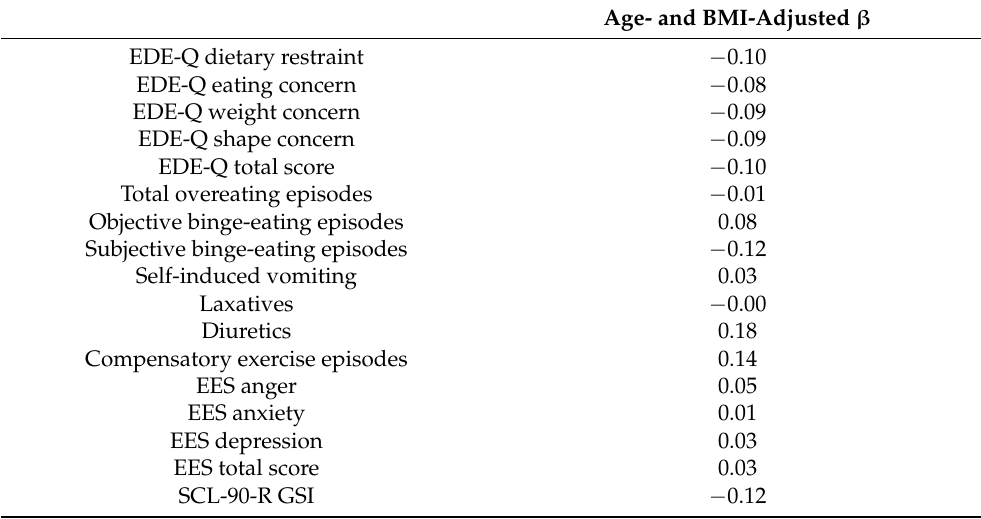
Table 3. Psychopathological and behavioral correlates of adiponectin (ADPN) levels in Eating Disorder (ED)